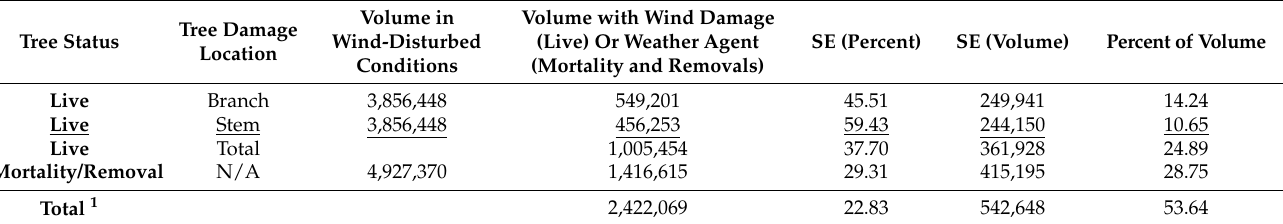
Table 2. Regional sound bole volume (m 3 ) of live, mortality, and removal trees ( ≥ 12.7 cm/5 in d.b.h.) on wind-disturbed forest land, by tree status/damage/breakage category, 2013–2019, in 221 counties within 200 km of IDDS counties, USA. Sampling errors represent ± 1 standard error